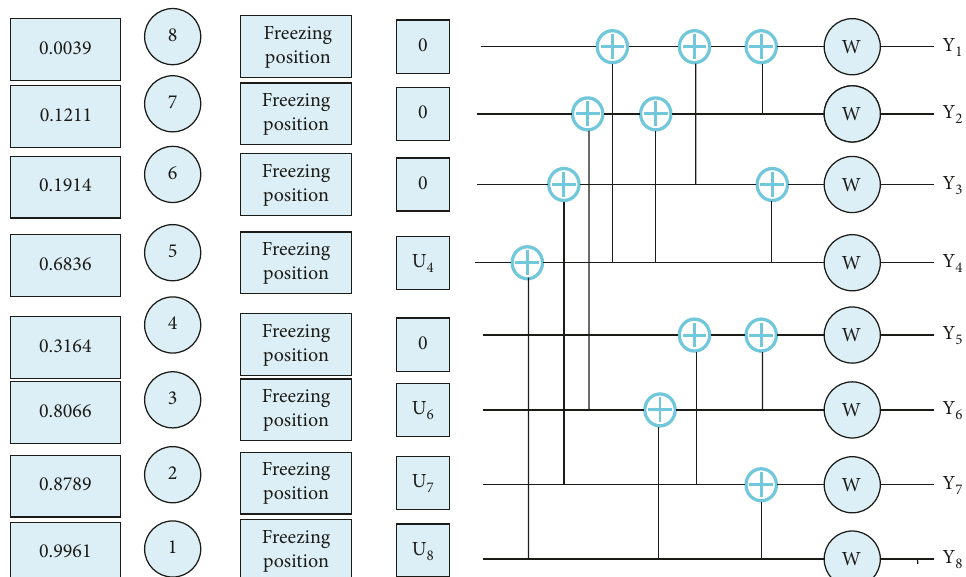
Figure 10: Polarization channel and structure of polar codes.